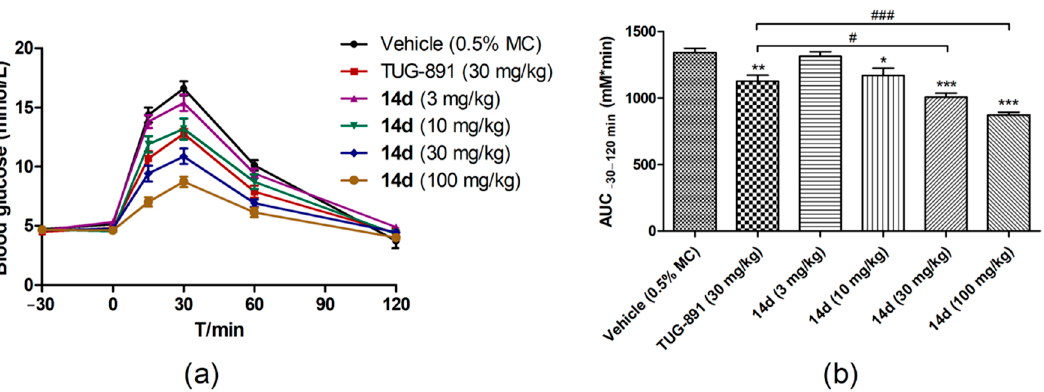
Figure 3. Effects of compound 14d and TUG-891 on plasma glucose levels during the OGTT in fasting C57BL/6 mice. ( a ) Time-dependent changes of blood glucose levels after oral administration of compound 14d , followed by the oral glucose load (3 g/kg). ( b ) AUC − 30–120 min of plasma glucose levels. Values are expressed as the mean ± SD ( n = 8). * p ≤ 0.05 compared with vehicle-treated C57BL/6 mice by Student’s t test; ** p ≤ 0.01 compared with vehicle-treated C57BL/6 mice by Student’s t test; *** p ≤ 0.001 compared with vehicle-treated C57BL/6 mice by Student’s t test; # p ≤ 0.05 compared with TUG-891-treated C57BL/6 mice by Student’s t test; ### p ≤ 0.001 compared with TUG-891-treated C57BL/6 mice by Student’s t test.